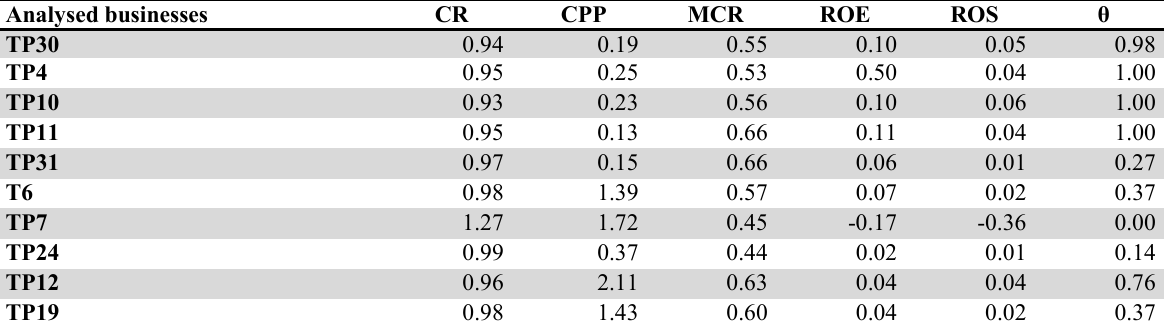
Efficiency of the analysed